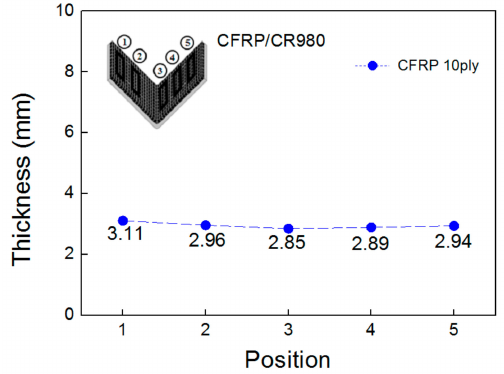
Figure 11. The thickness of the CFRP/CR980 conducted by V-bending test at different positions.